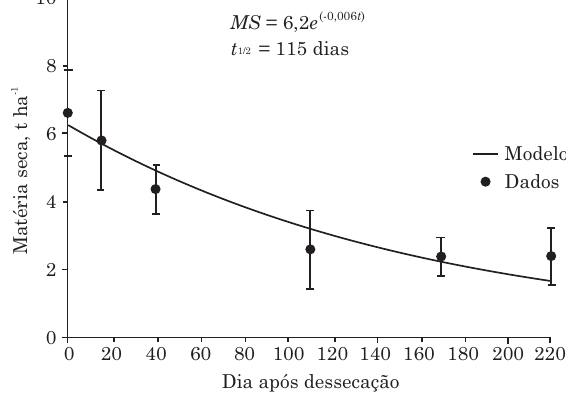
Figura 1. Valores médios de temperatura máxima (Tmax), mínima (Tmin) e média (Tmed), umidade relativa do ar (UR) e valores acumulados de precipitação pluvial ao longo dos meses de outubro de 2008 a maio de 2009.